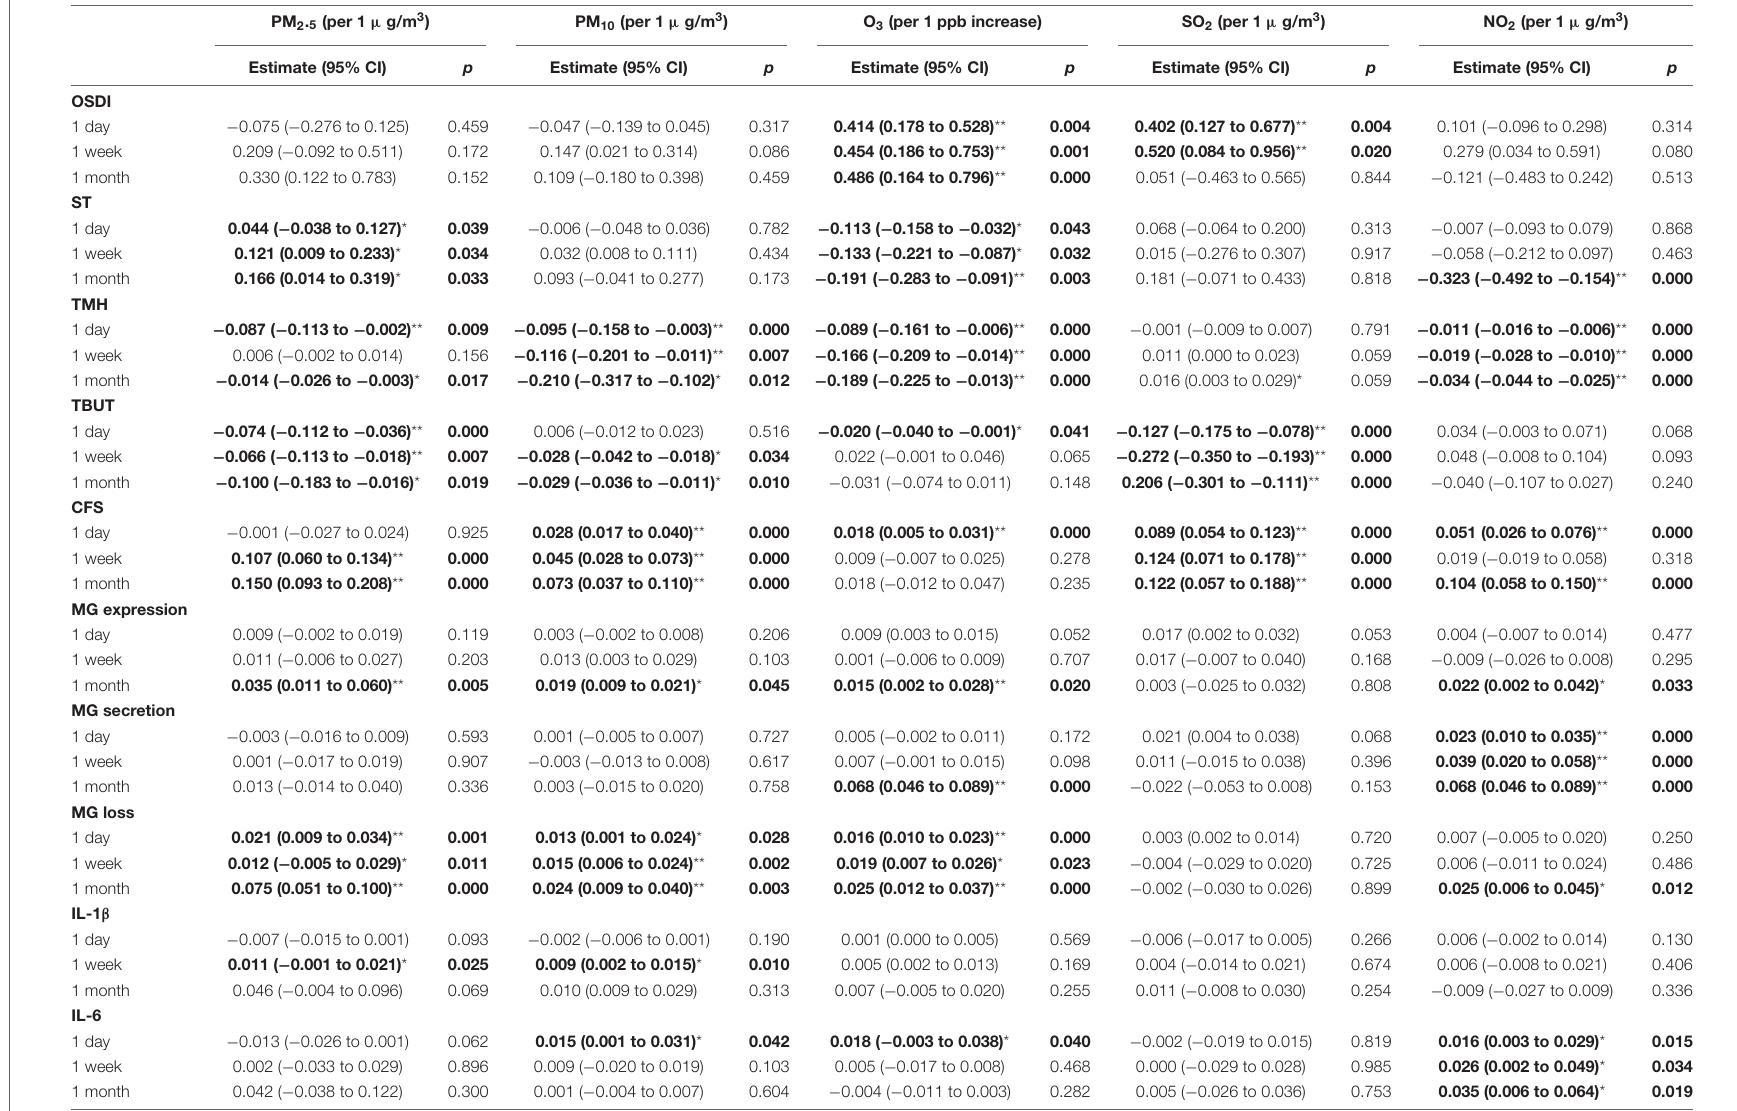
TABLE 3 | Effects of air pollutants on ocular surface using single-pollutant